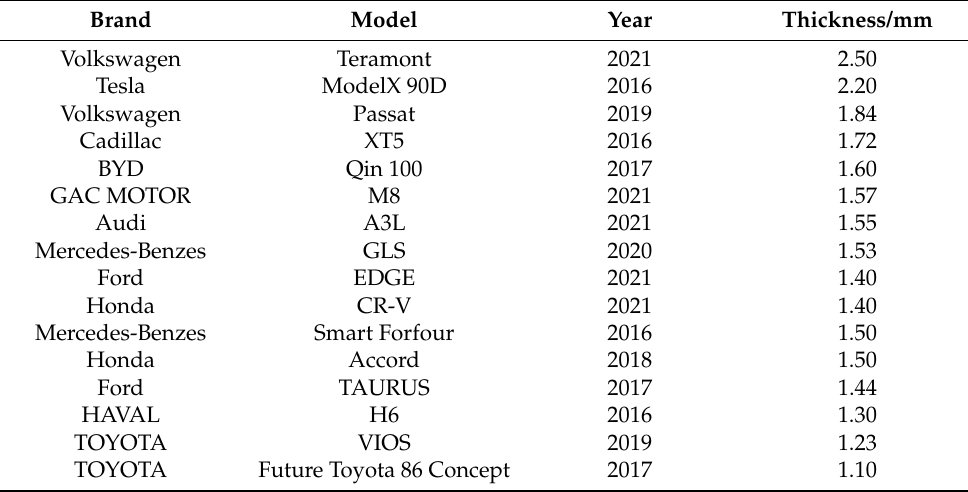
Figure 2. Steel bumper beam and crash box of Haval H2. ( a ) Front frame, ( b ) rear bumper beam, ( c ) front bumper beam and steel buffer plate, ( d ) left crash box, ( e ) right crash box. Table 2. Steel front bumper beam thickness of different vehicles.